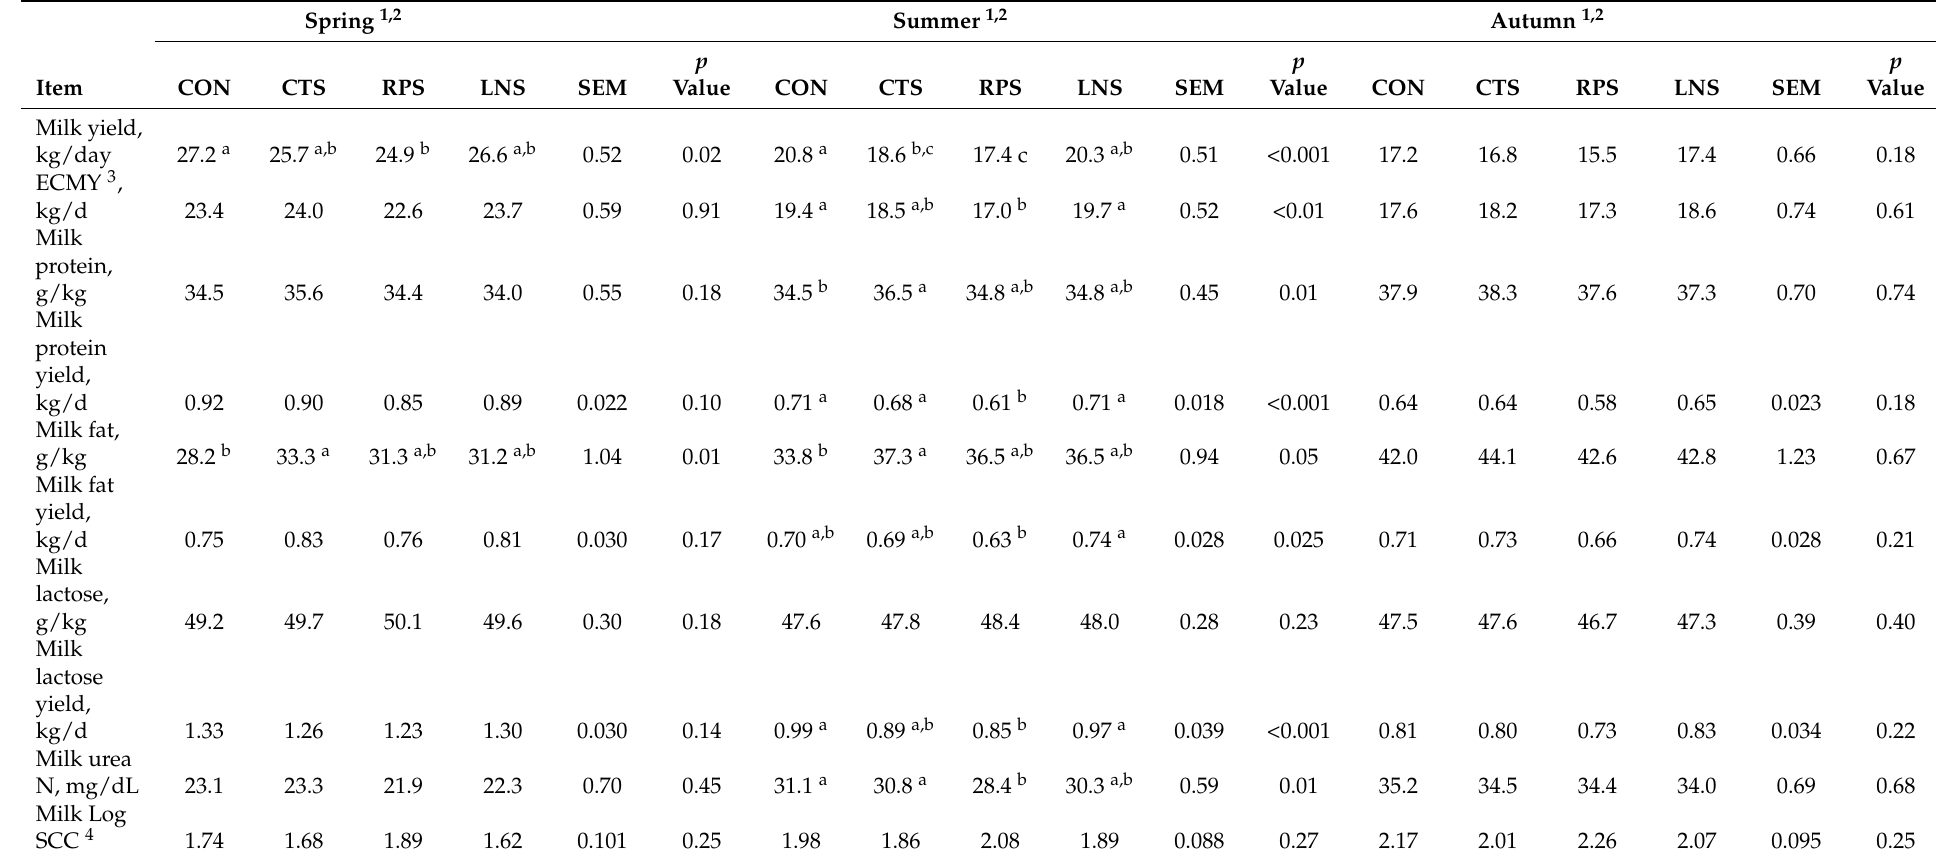
Table 3. Effects of oilseed supplementation on milk and milk component yield, milk composition throughout the study. Spring